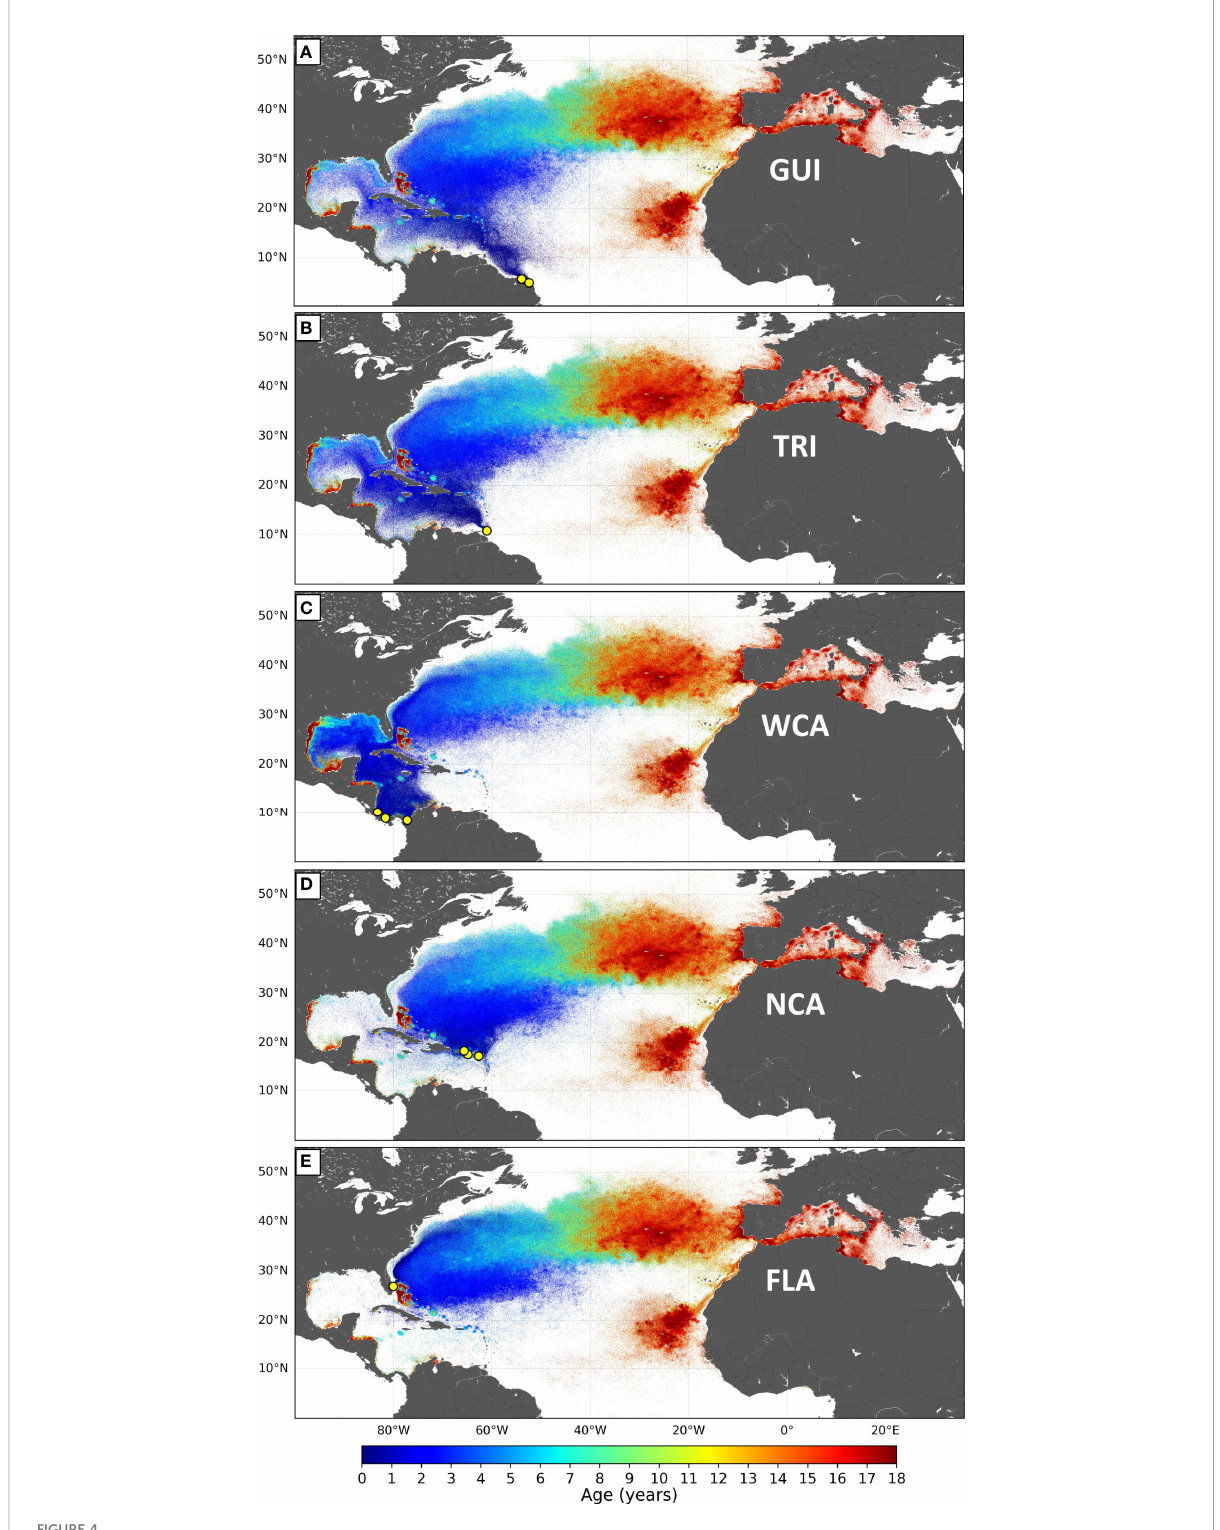
FIGURE 4 (A – E) Normalized maps of the dispersal patterns simulated for the fi ve stocks of the NWA leatherback subpopulation. Each map contains 5 million positions, the color of which varies with the age of the simulated